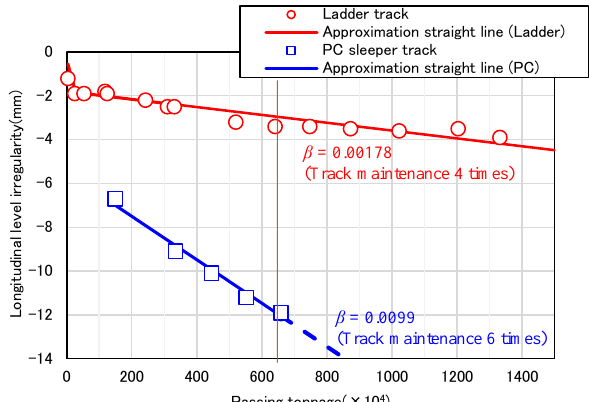
Figure 22. Comparison of the longitudinal level irregularity of the ballasted ladder track and PC sleeper track.